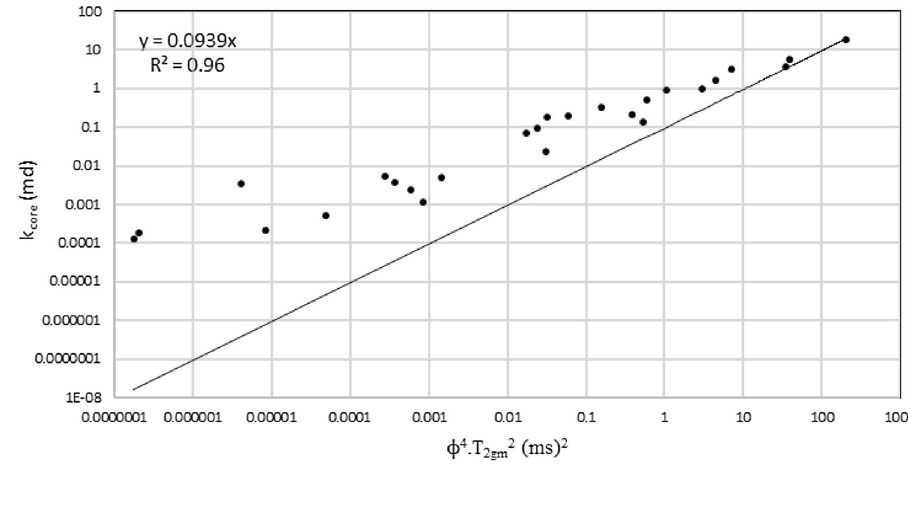
Fig. 9 Correlation of estima- tion SDR permeability and core permeability ( m = 4, n =